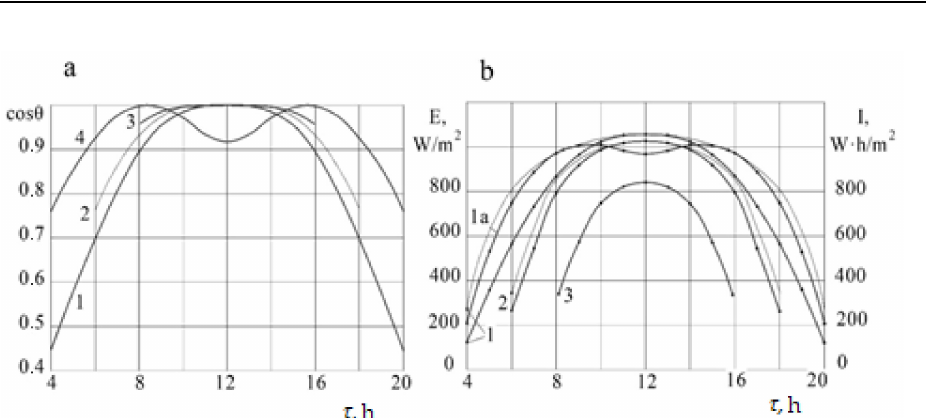
Figure 12. Orientation ( a ) and exposure ( b ) efficiency of vertical rotation surface in the periods (own research): summer solstice at the angle of inclination 26.55 ◦ and 50 ◦ respectively; 2—spring equinox β = 50 ◦ ; 3—winter solstice β = 73.45 ◦